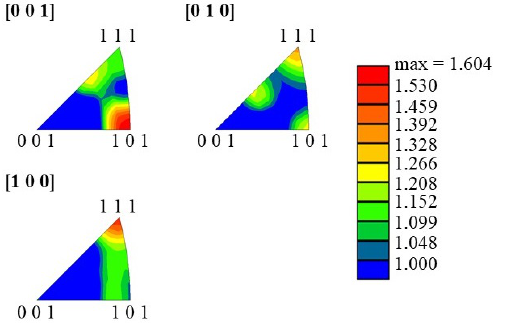
Figure 10. Inverse pole figures of WAAM AA2319 with an intensity maximum of H max = 1.604